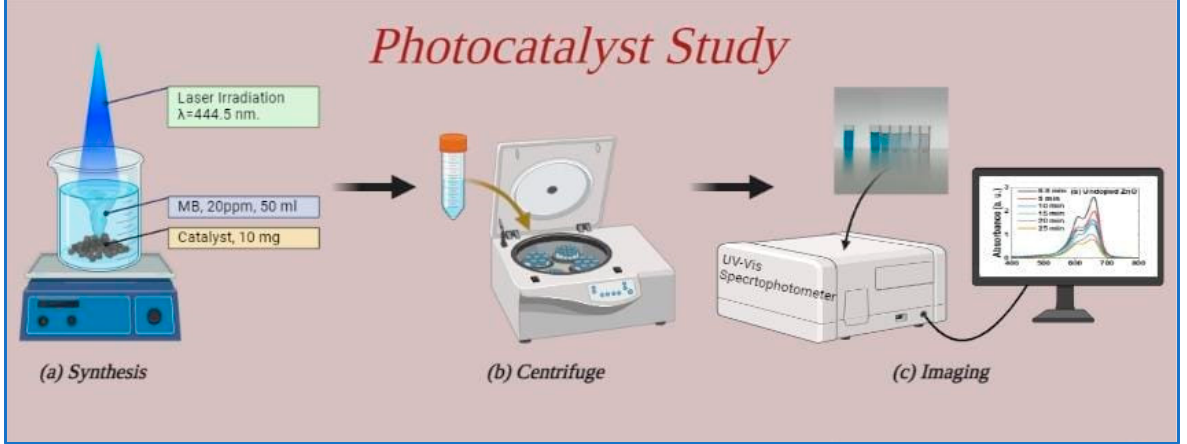
Figure 3. Schematic diagram and illustration of the photocatalyst